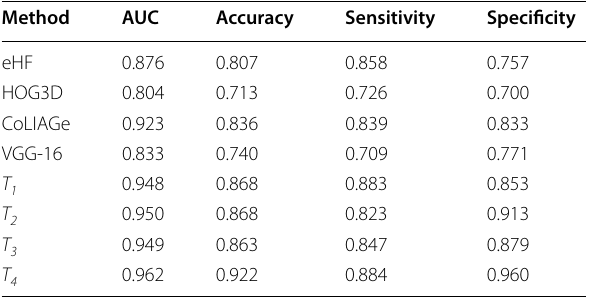
Table 8 AUC, accuracy, sensitivity, and specificity values from comparative methods and our proposed method where HF represents Haralick feature